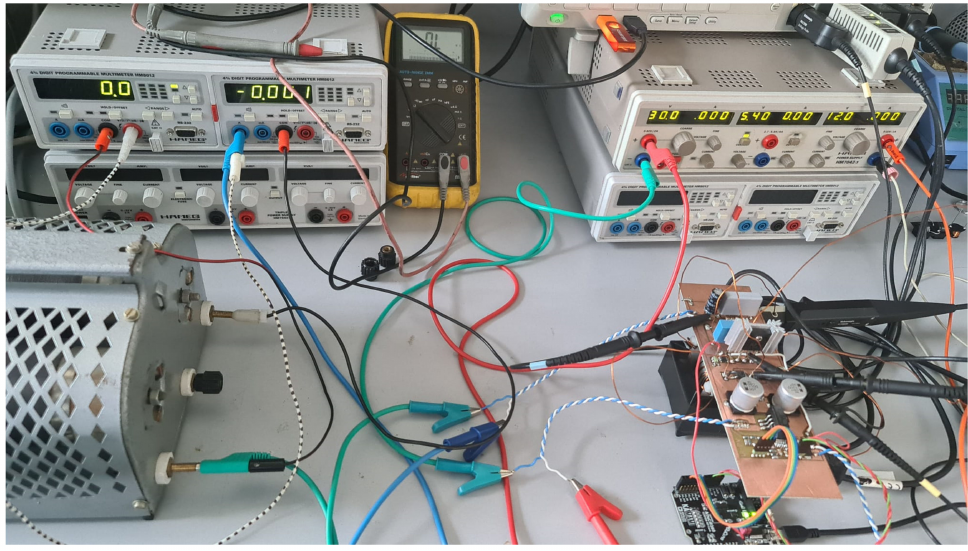
Figure 19. View of the experimental setup.